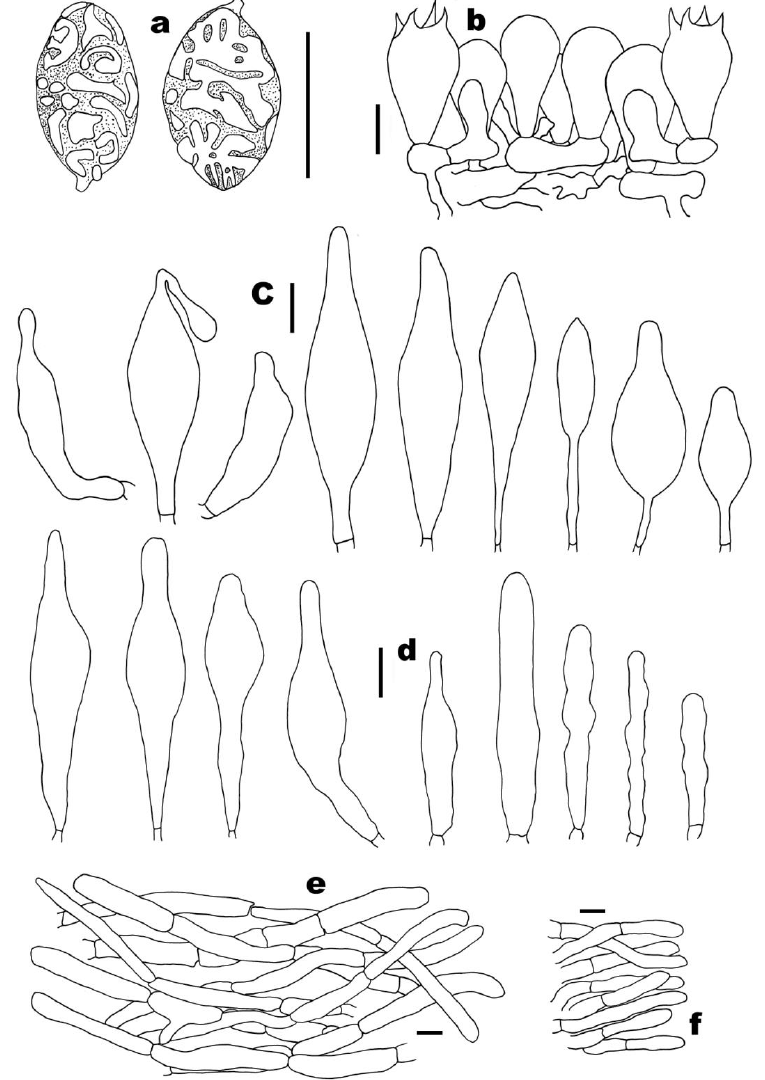
Figure 3. Microscopic features of Austroboletus brunneisquamus (FHMU5876, holotype). ( a ) Basidiospores. ( b ) Basidia. ( c ) Cheilocystidia. ( d ) Pleurocystidia. ( e ) Pileipellis. ( f ) Stipitipellis. Bars = 10 μm. Drawings by C. Xu.